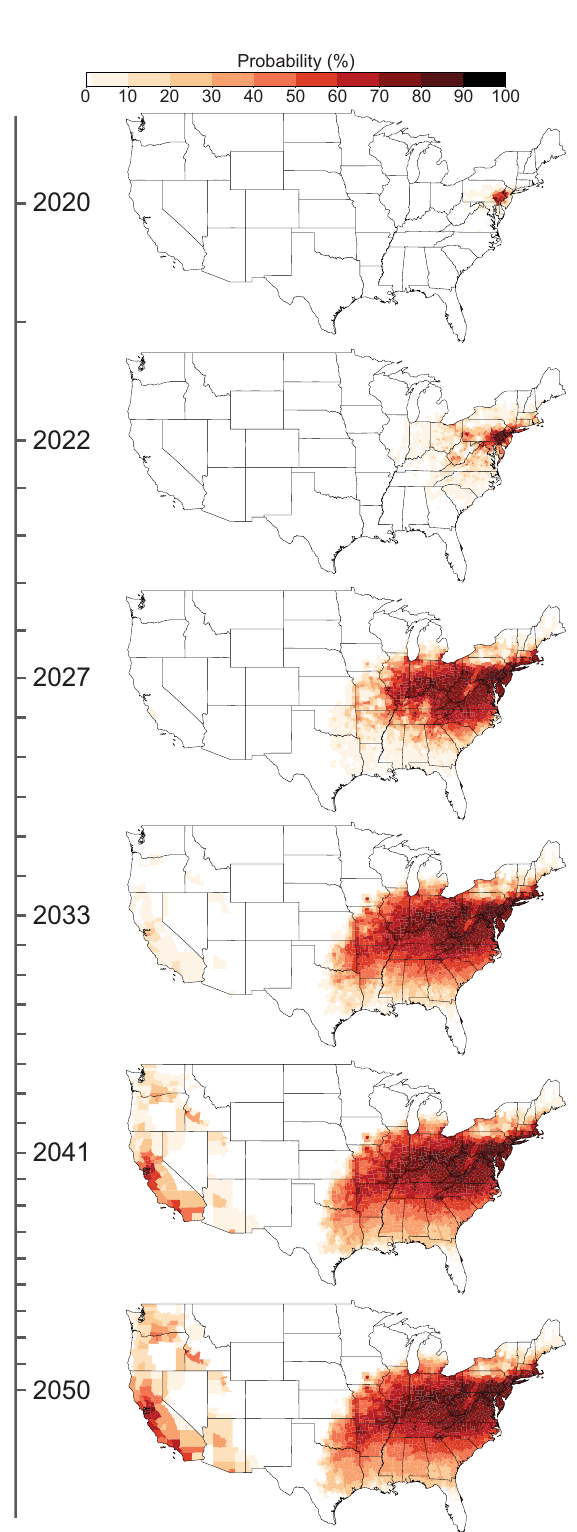
Fig. 1 Spread probability over time using the mean of all raster cells in a county. By 2027 there is a low probability of SLF infestation in California, and by 2033 the fi rst county in California has a high probability of SLF